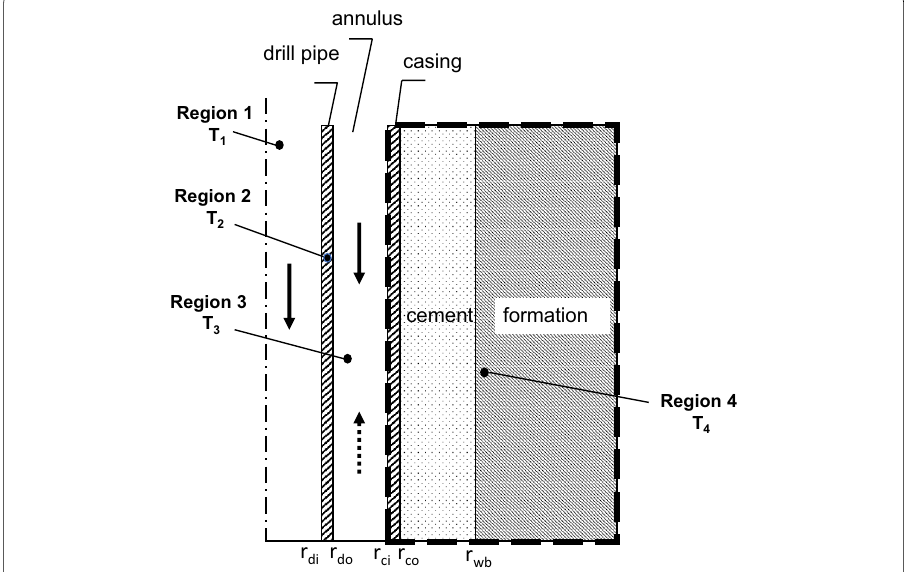
Fig. 1 Schematic of the heat exchange model between the wellbore and the formation. Governing equations are solved in four regions: the fluid inside the drill pipe (region 1), the drill pipe wall (region 2), the annulus (region 3), casing-cement-formation (Region 4). The solid arrow pointing downwards and the dashed arrow pointing upwards in the annulus refer to coflow and counterflow scenarios in the wellbore,